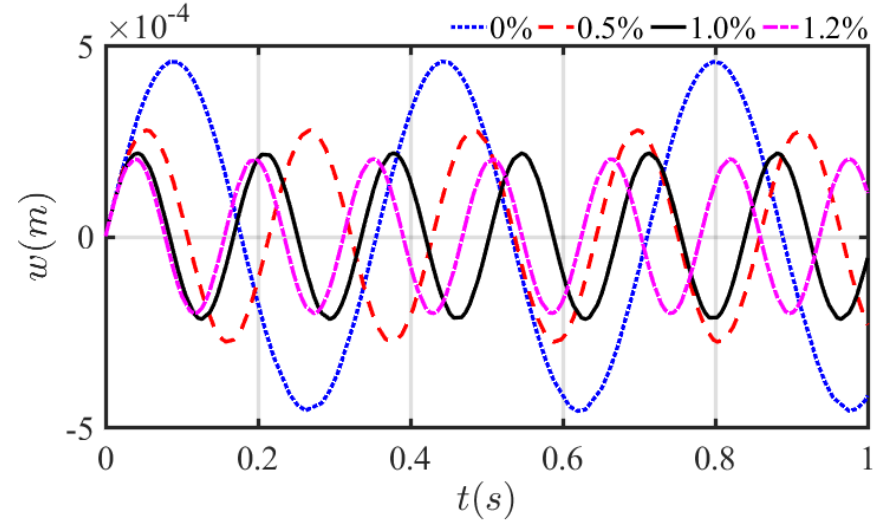
Figure 10. Effect of GPL mass fraction on pipes conveying fluid nonlinear transient vibration.